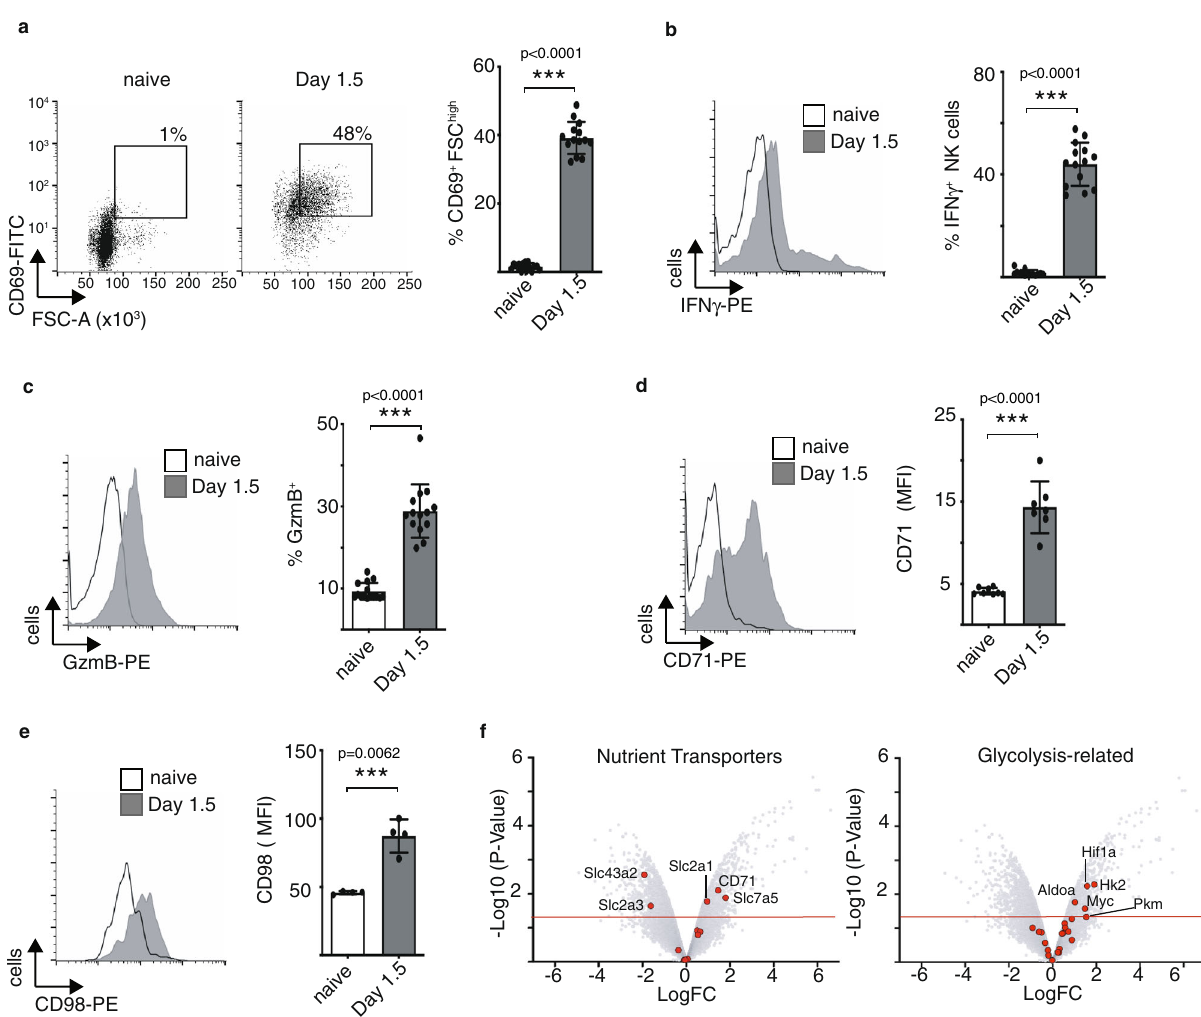
Fig. 4 Metabolism of NK cells after acute MCMV infection. C57BL/6 mice were infected with MCMV (Smith strain) or used uninfected and spleens were harvested at 1.5 days. NK cells (CD3 − NKp46 + ) were analysed for activation (CD69) and cell size (FSC-A) ( a ). Ex vivo restimulated NK cells were analysed for IFN γ ( b ). Cytotoxicity was detected by granzyme B expression ( c ). A representative histogram and bar graphs of CD71 and CD98 are shown in d and e . A minimum of four ( e ) or seven ( a – d ) mice per group were used and analysed by a two-sided unpaired t -test and displayed± SEM. ** p < 0.01, *** p < 0.001. f Volcano plots of nutrient transporters and glycolysis-related genes displaying differences in relative gene expression after MCMV infection. The plot represents the − log10 of the p -value against log2 fold change. The horizontal red line represents a p -value <0.05. Source data are provided as a Source Data